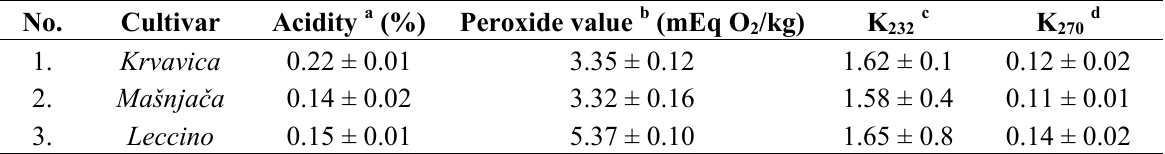
Table 1. Mean values of basic quality indices (% acidity, peroxide value, K Mašnja č a , Krvavica and Leccino